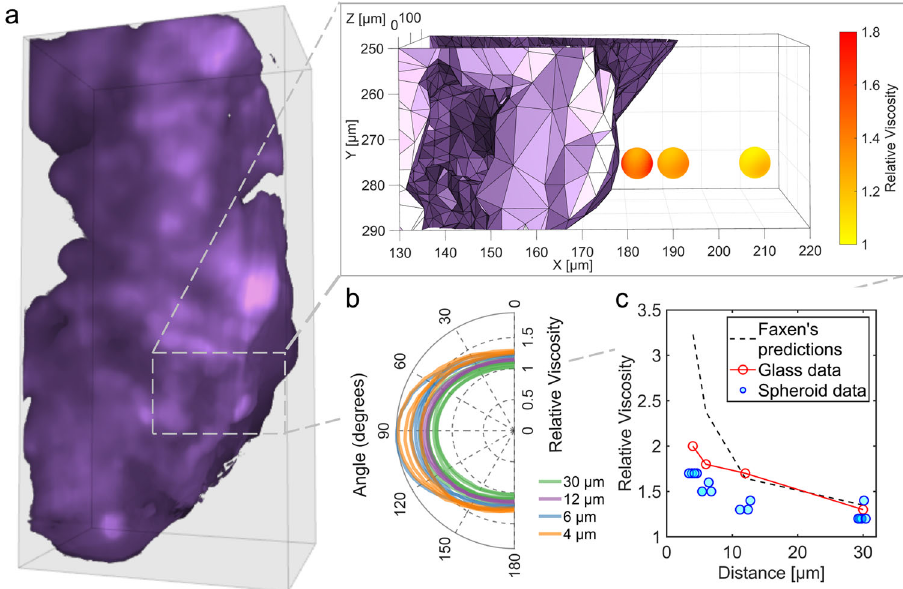
Fig. 6 Viscosity near spheroid. a 3D rendering of a section of a spheroid of MCF-7 cells expressing td-Tomato (relative dimensions: 200 µ m × 400 µ m × 100 µ m (150 – 250 µ m from the coverslip)). The inset shows one of the areas where viscosity (relative to the solvent) measurements were acquired at incremental distances from the spheroid surface — three measurements (4 µ m, 12 µ m and 30 µ m from the spheroid surface) are depicted as spheres (not to scale). The colour gradient for each sphere represents the relative viscosity sampled by angle at each measurement position. A fourth position (6 µ m) has not been shown to aid visualisation. b Relative viscosity measurements in a plane perpendicular to the spheroid surface, passing through the highest and lowest measured viscosity at the probe position n = 18. c Relative viscosity measurements of the nutrient media at each position for a direction perpendicular to the spheroid surface (blue with jitter applied to data) and glass (red), showing increased apparent viscosity at positions closer to the surface but lower than values predicted from Faxén ’ s law (black dashed